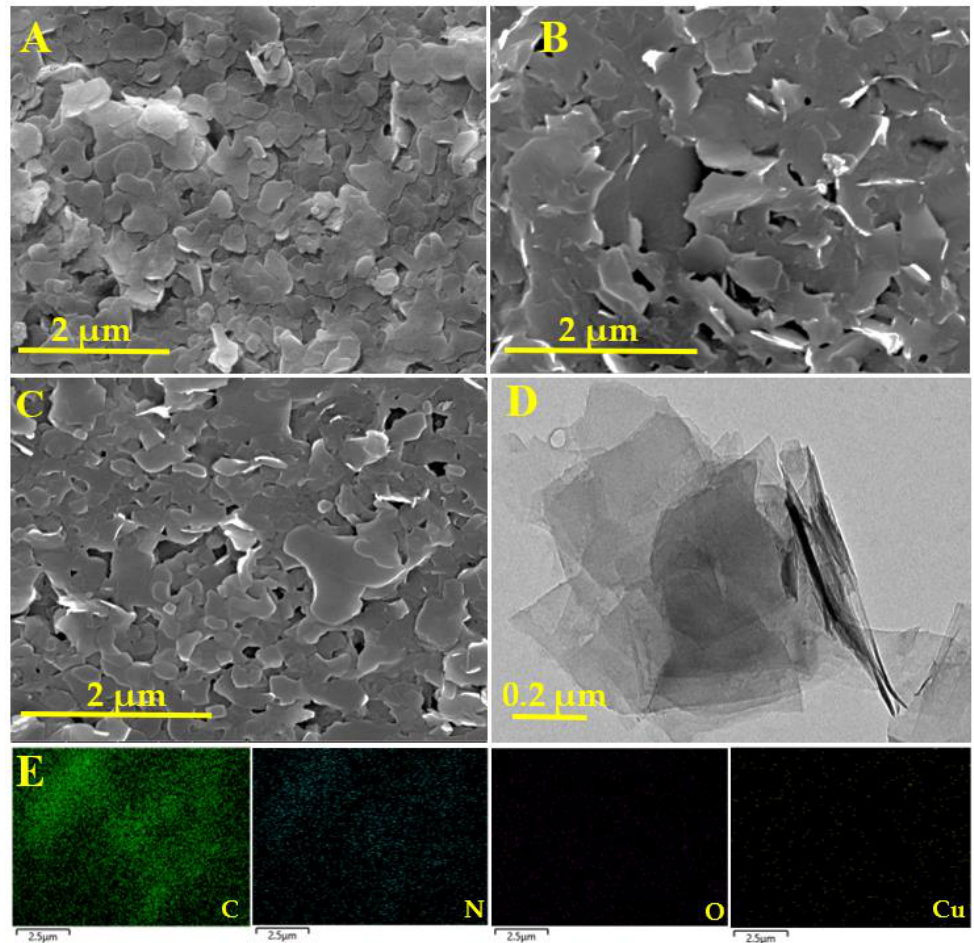
Figure 2. SEM images of Cu-TCPP ( A ), graphene ( B ), and Cu-TCPP/graphene composite ( C ); ( D ) TEM image of Cu-TCPP/graphene hybrid; ( E ) elements mapping images of Cu-TCPP/graphene hybrid.